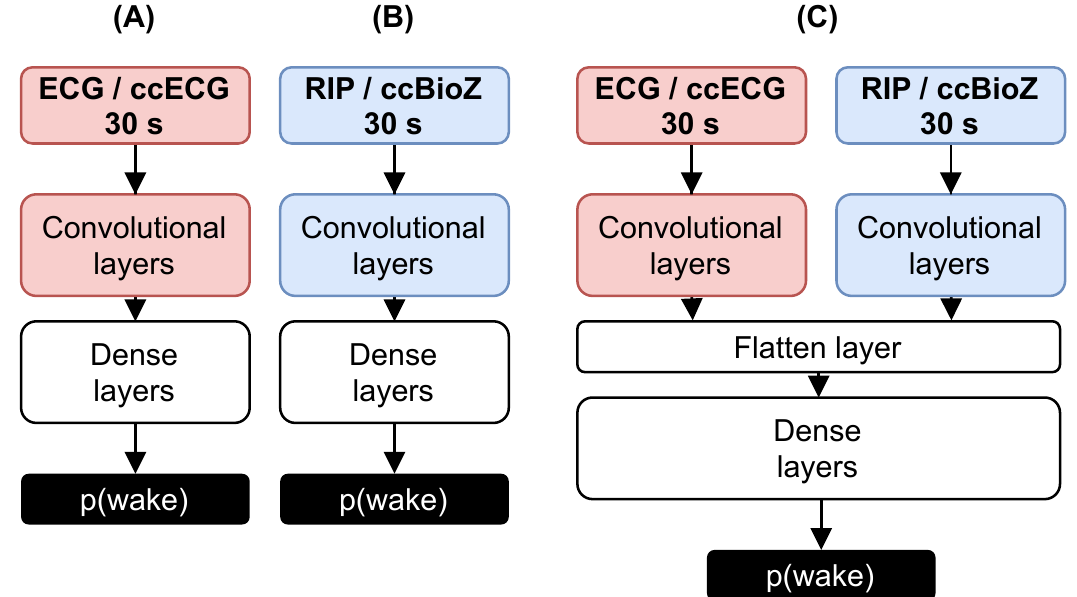
Figure 3. Sleep–wake classifiers. ( A ) Unimodal network for cardiac input and ( B ) for respiratory input. ( C ) Multimodal net- work consisting of two branches. The left branch received tachograms and the right branch received respiratory